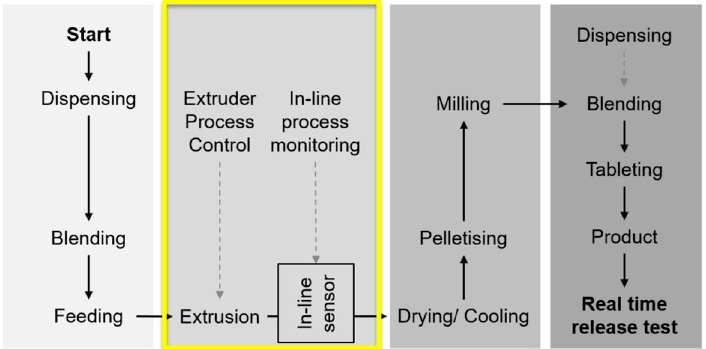
Figure 1. Schematic diagram showing the manufacturing process including the main unit operations from powders to final product, tablets [10]. The focus of this study is on the in-line UV-Vis monitoring of the hot melt extrusion (HME) process. Reproduced with permission from Lundsberg et al.,